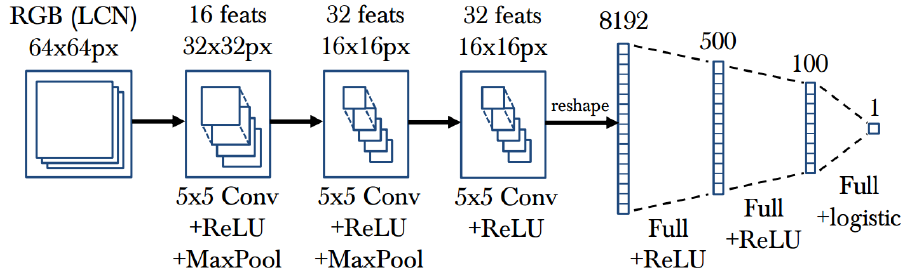
Figure 13. The convolutional network architecture used in [156]. It includes: one input layer, two convolution and down sampling layers, one convolution layer, two fully connected layers, one logistic regression layer, and one output layer. Note, “LCN” stands for local contrast normalization, and ReLU and logistic are activation